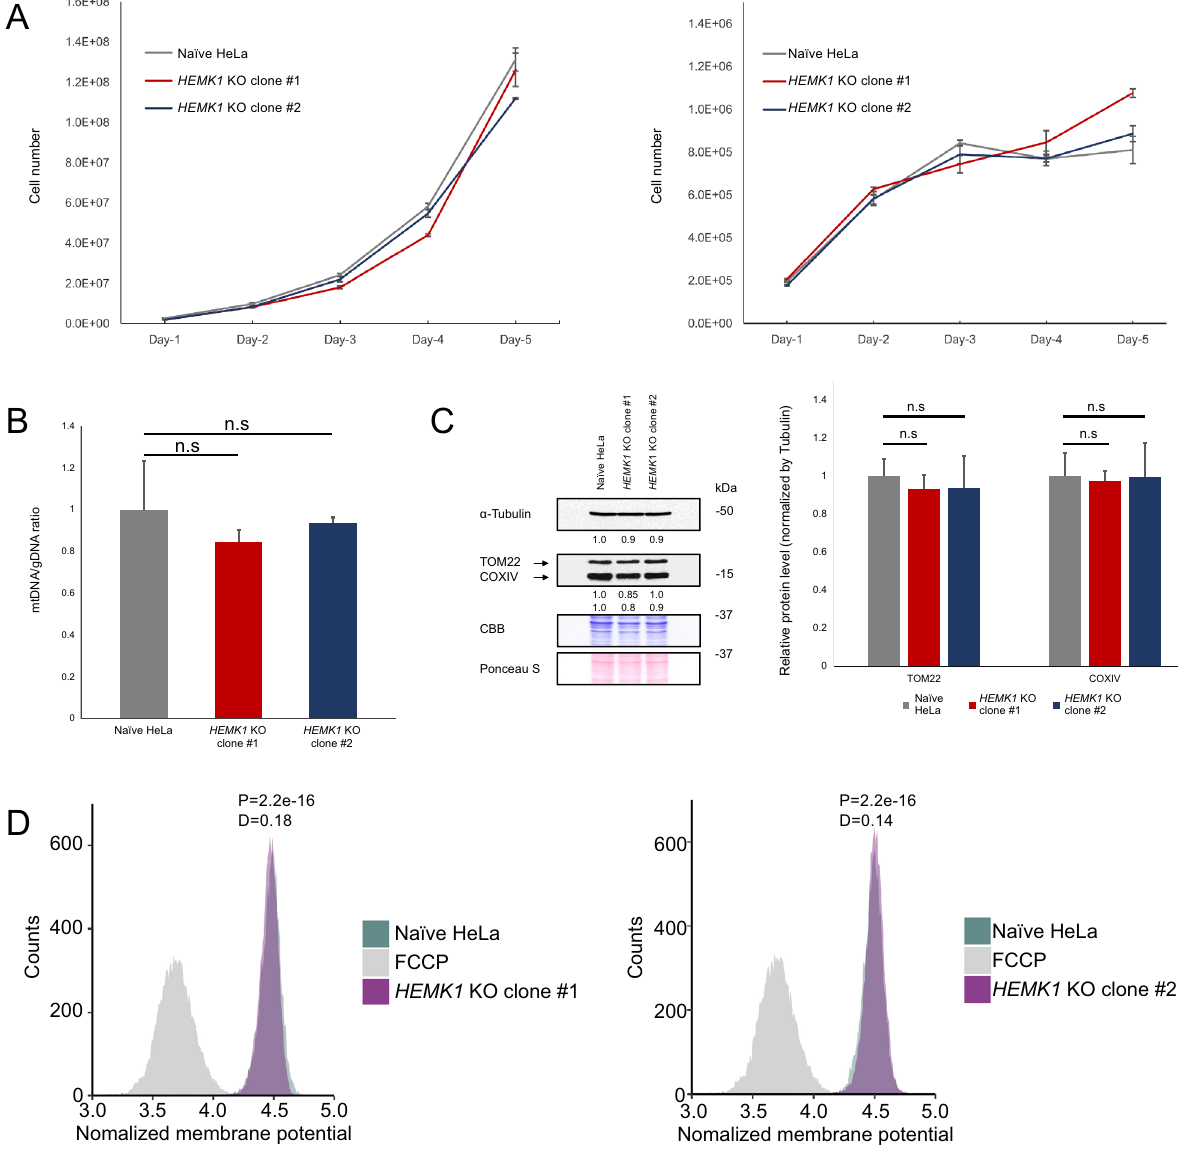
Figure 3. Impacts of HEMK1 depletion on cell growth and mitochondrial properties. ( A ) Cell growth in high-glucose and galactose media. Growth curve of naïve HeLa and HEMK1 KO clones #1 and #2 in different media. Left panel: high-glucose media; right panel: galactose media. The numbers represent a mean ± SEM from three independent samples. ( B ) Assessment of relative mtDNA amounts (mtDNA/gDNA) by qPCR. Data were normalized to gDNA abundance. Data represent a mean ± SEM from three independent samples. The Student’s t-test, two-tail, was used for testing the statistical significance. n.s not significant. ( C ) Western blot of mitochondrial outer membrane protein TOM22, and inner membrane protein COXIV from naïve HeLa and HEMK1 KO clones (#1 and #2). Left panel shows representative western blot result. α-Tubulin was used as a loading control. CBB and Ponceau S staining were shown as loading and transfer indicators. Numbers shown at the bottom of each panel indicated the normalized intensity referring to signals from naïve HeLa cells. Right panel: quantitation of mitochondrial membrane protein TOM22 and COXIV Western blot signals with a mean ± SEM from four independent samples. The Student’s t-test, two-tail, was used for testing the statistical significance. n.s not significant. Biological repeats were shown in Figures S6C and S9A–F. ( D ) Assessment of mitochondrial properties by FACS analysis. Mitotracker Red CMXRos signal was normalized with Mitotracker Green FM signal (see “Materials and methods” section for the details). Data from 10,000 cells are depicted. The Mann–Whitney U -test, two-tail, was used for testing the statistical significance (P value). The Cohen’s d-test was used for testing the effect size (D